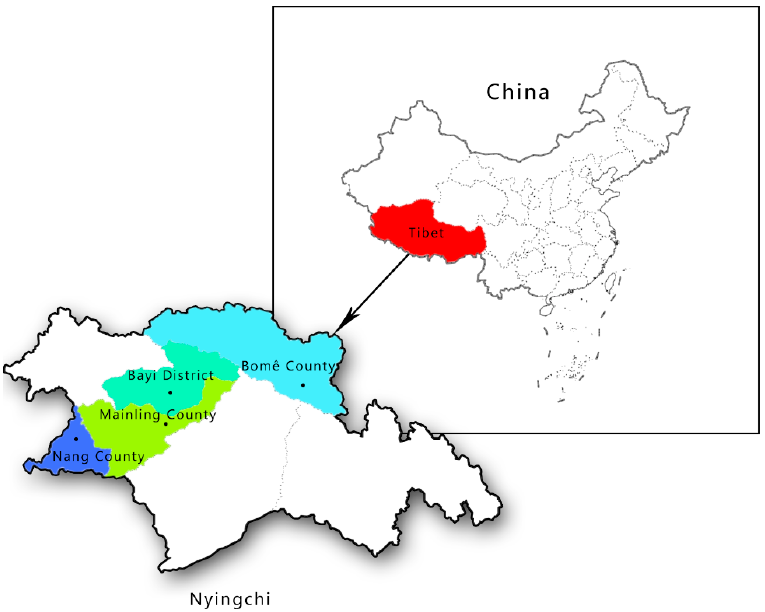
Figure 1. Map of the sampling area: Qinghai Tibet Plateau (with an average altitude of more than 4000 m), Nyingchi City (with an average altitude of about 3000 m).